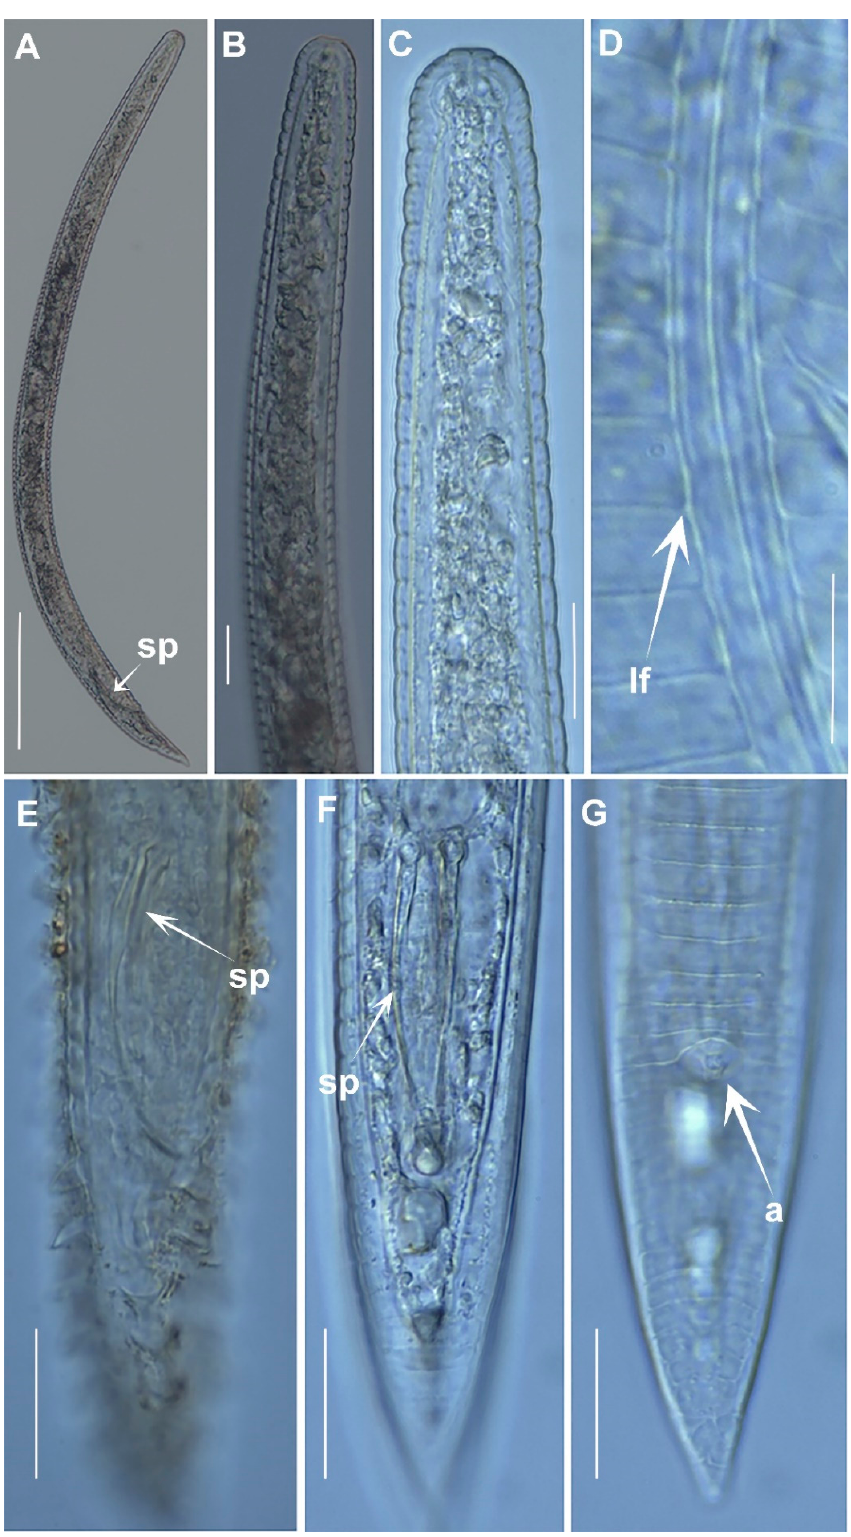
Figure 5. Light micrographs of Criconema pseudoannuliferum sp. nov. male. ( A ), whole male, showing spicules (arrowed); ( B , C ), male anterior region showing absence of stylet and undifferentiated pharynx. ( D ), male at mid-body showing detail of lateral field (arrowed); ( E – G ), male tail showing spicules and anus (arrowed). Abbreviations: a = anus; lf = lateral field; sp = spicules. Scale bars: ( A ) = 100 µm; ( B – G ) = 20 µm.